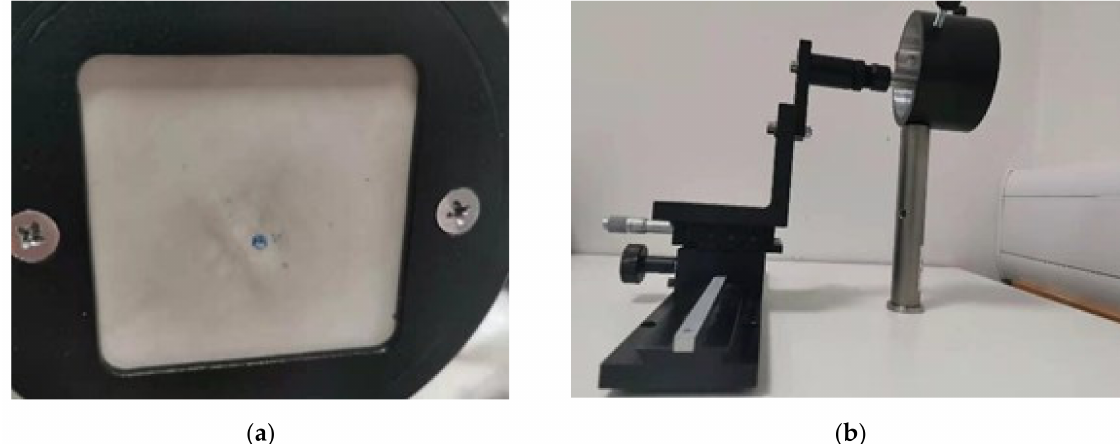
Figure 4. ( a ) Sample composite surface; ( b ) A continuous force used as the loading method exerted on the composite